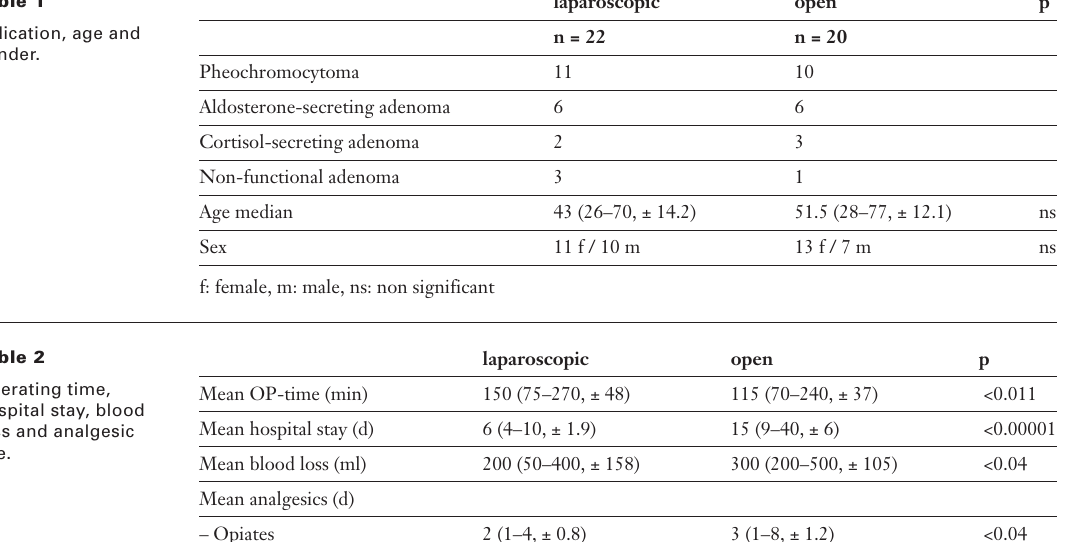
Indication, age and gender.